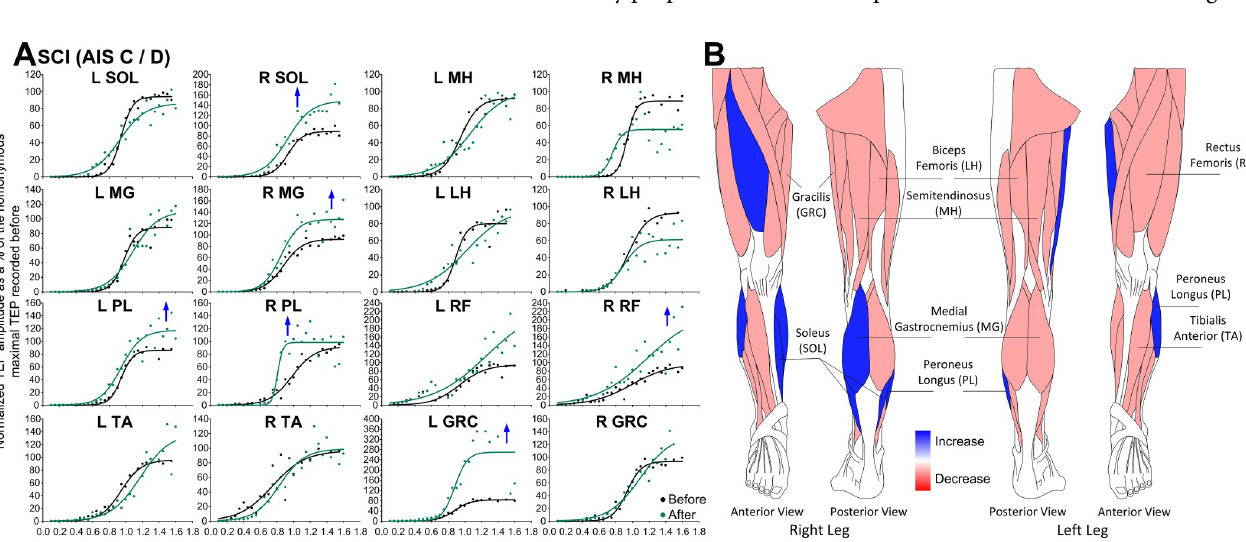
TEP onset latencies (ms) in comparison to the soleus (SOL) H-reflex. MG: medial gastrocnemius; PL: peroneus longus; TA: tibialis anterior; MH: medial hamstring; LH: lateral hamstring; RF: rectus femoris; GRC: gracilis. Based on Student’s t -test, italics indicate a significant difference on latencies across subject groups.